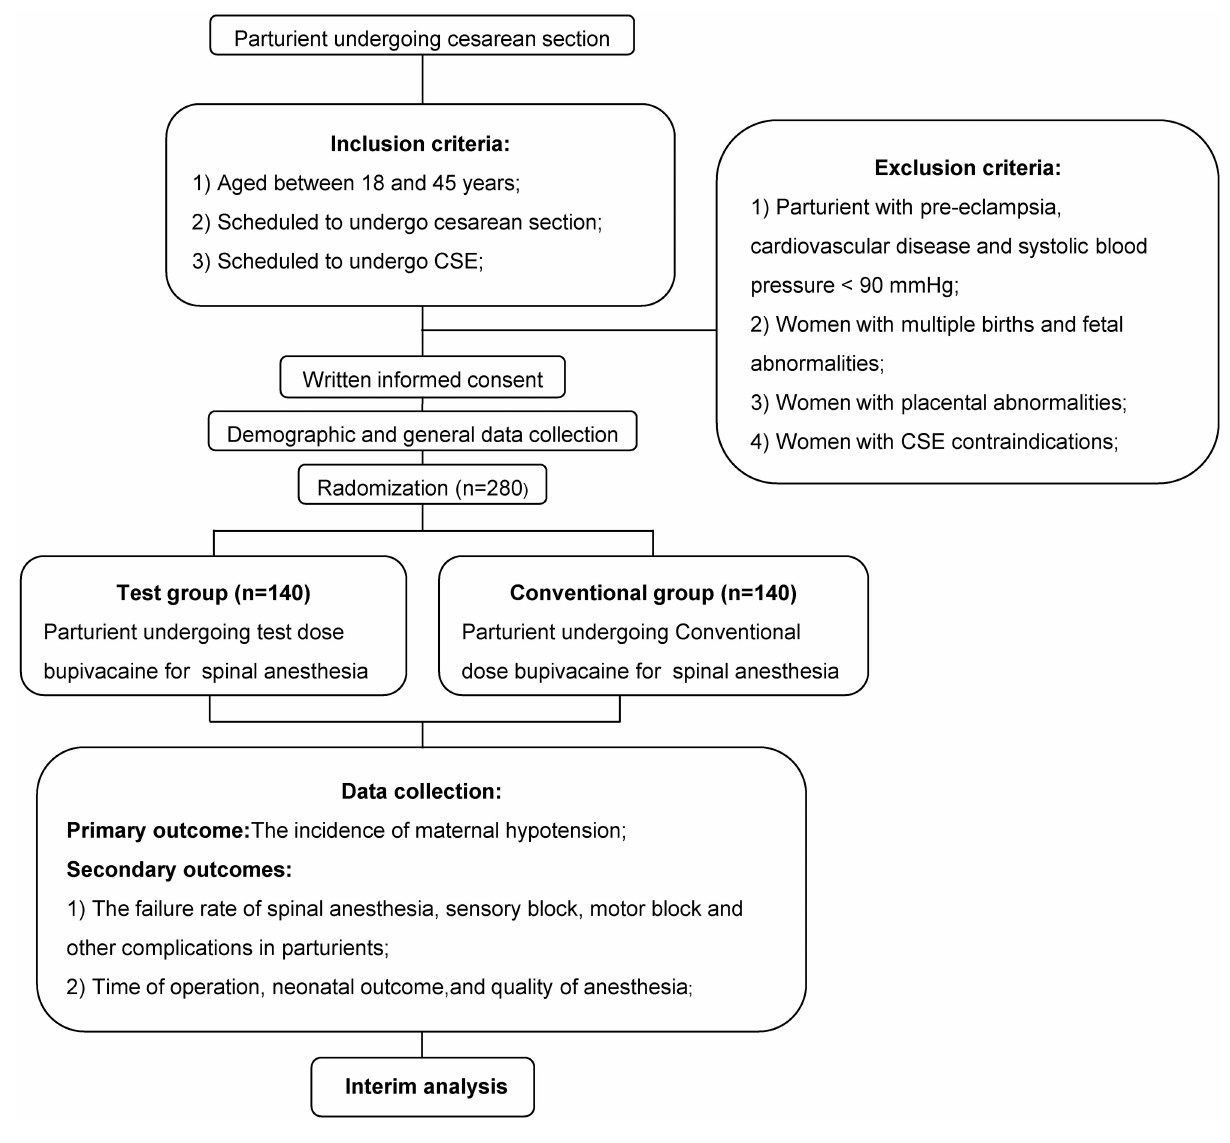
Maternal hypotension was defined by SBP < 90 mmHg or 70% of baseline value. From anesthesia initiation to delivery, when maternal hypotension occurred, this parturient was defined as a parturient with hypotension. Maternal hypotension was treated with phenylephrine (100 µ g). Bradycardia ( < 60 beat/min) was treated with atropine (0.5 mg). Nausea and vomiting were treated with metoclopramide (10 mg). According to anatomical structure, for cesarean section, it is recommended that the highest sensory block level should reach dermatome level dominated by the fourth thoracic nerve (T4) (23). However, in different studies, the highest sensory block level is required to reach T4, T5, T6, or T8 (5, 14, 20, 24–26). In some parturients, even though the highest sensory block level reaches T4, they still feel slight pain